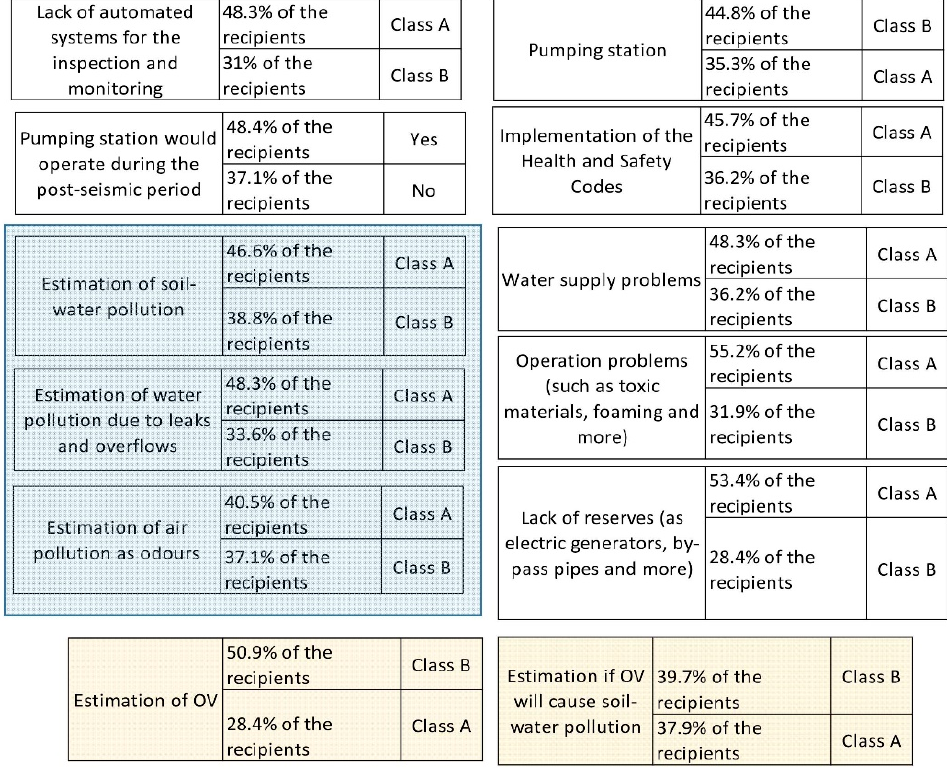
Figure 10. OV characteristics of the WWTPs in the post-seismic period in Greece.